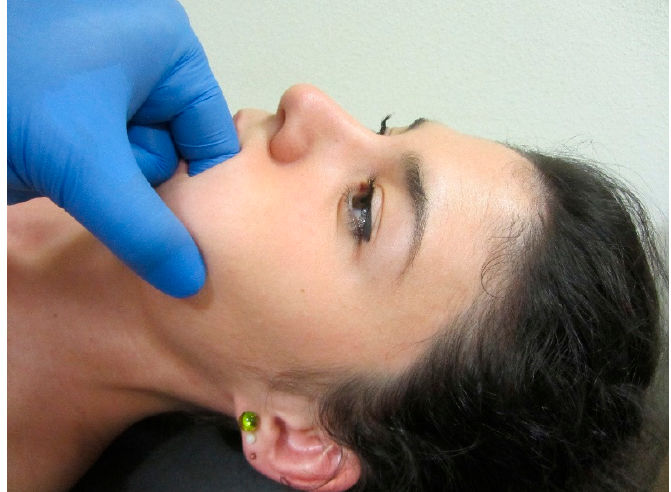
Figure 4. Intra ‐ oral pincer compression of masseter muscle. Copyright Handspring Publishing Limited 2018. Reproduced with permission. Illustrations first published in Temporomandibular Disorders edited by César Fernández ‐ de ‐ las ‐ Peñas and Juan Mesa ‐ Jiménez, Handspring Publishing Limited, 2018.